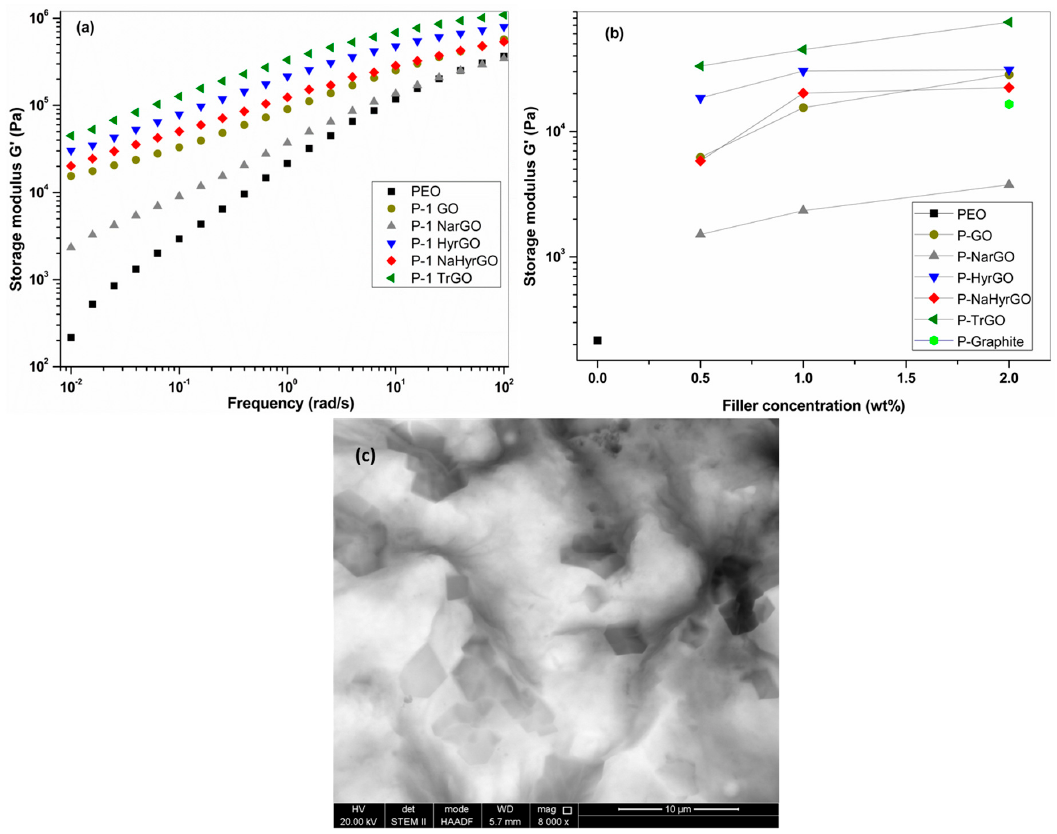
Figure 6. Viscoelastic properties ( a ) storage modulus ( G ˊ ) at 1 wt % loading, ( b ) storage modulus ( G ˊ ) at 0.01 rad/s versus filler concentration (wt %) of PEO-based nanocomposites with graphite, GO and rGO, and ( c ) representative STEM image of P-2 NaHyrGO nanocomposite.